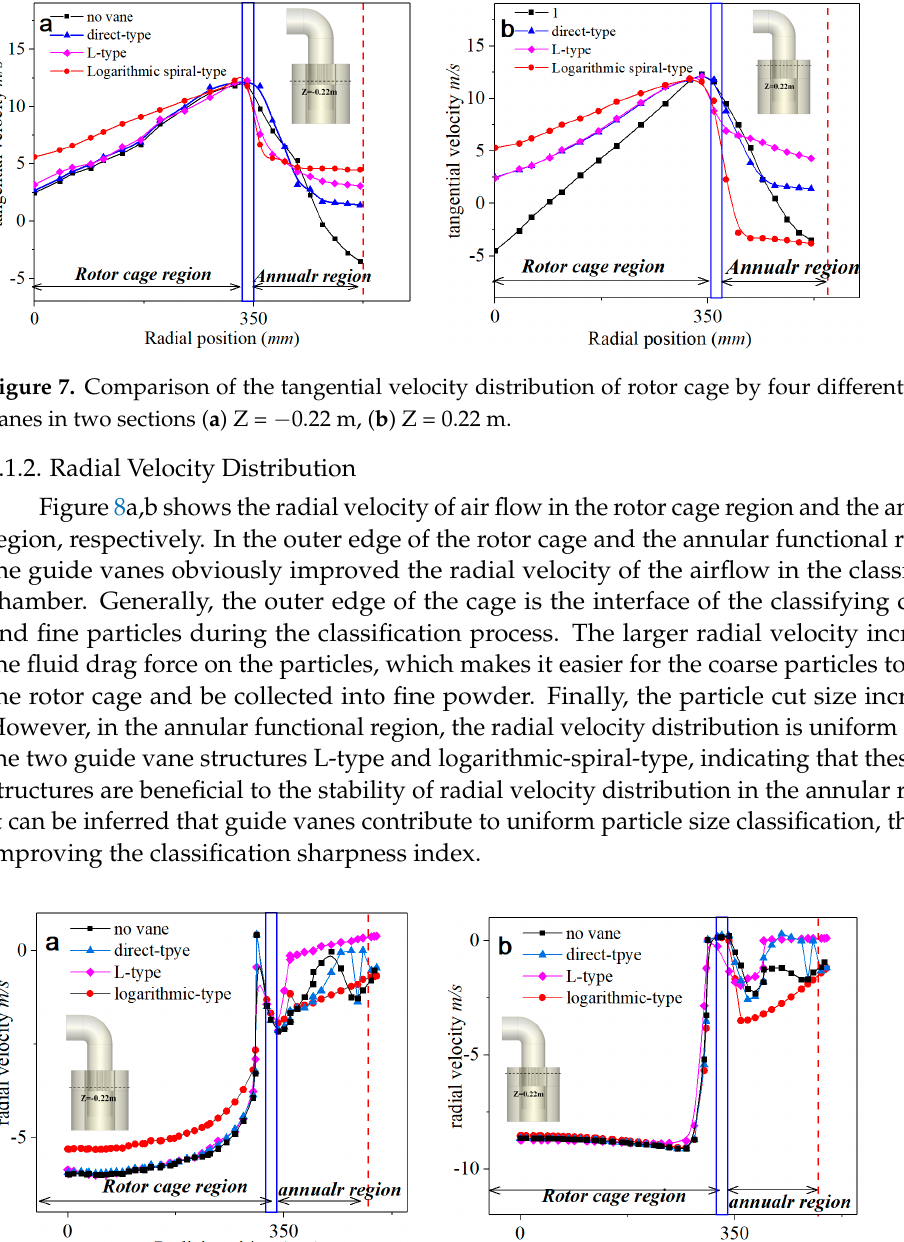
Figure 7. Comparison of the tangential velocity distribution of rotor cage by four different guide vanes in two sections ( a ) Z = − 0.22 m, ( b ) Z = 0.22 m.